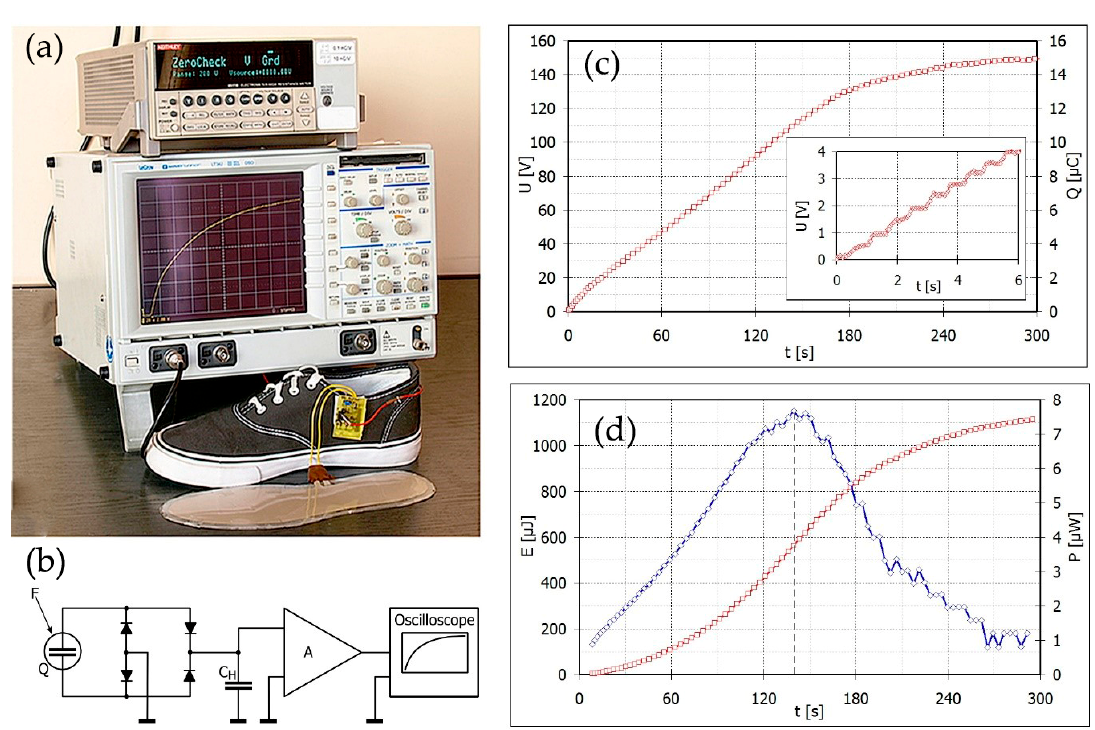
Figure 4. ( a , b ) General view and an electric scheme of the measuring set for the electric signal and mechanical electro-transformer as a shoe insert (Q: Source of piezoelectric charge, C H : Harvesting capacitor, A: Amplifier, F: Acting force), ( c ) speed and the mode of charging capacitor (the inset contains the enlarged part of the curve for the first 6 s), ( d ) dependence of energy and the capacitor’s power vs. walking time. Non-oriented film of i-PP with 10 wt% Sillikolloid P87 was used for the fabrication of the piezoelectric element.